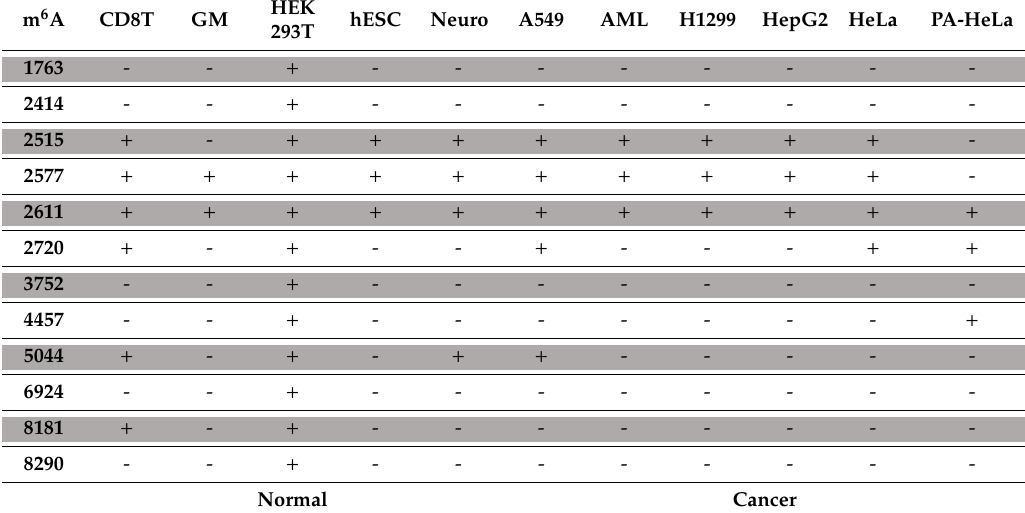
Table 1. m 6 A marks in MALAT1 isolated from several human cell lines. All data were obtained from the m 6 AVar database [42,43,59]. “ + ” represents the presence of an m 6 A mark and “-” represents the absence of an m 6 A mark. Abbreviations for select human cell lines are as follows: CD8T are CD8-positive T cells, GM are GM12878 cells, hESC are human embryonic stem cells, Neuro are neuroprogenitor cells, and PA-HeLa indicates that photoactivatable crosslinks were generated in HeLa cells when preparing RNA for